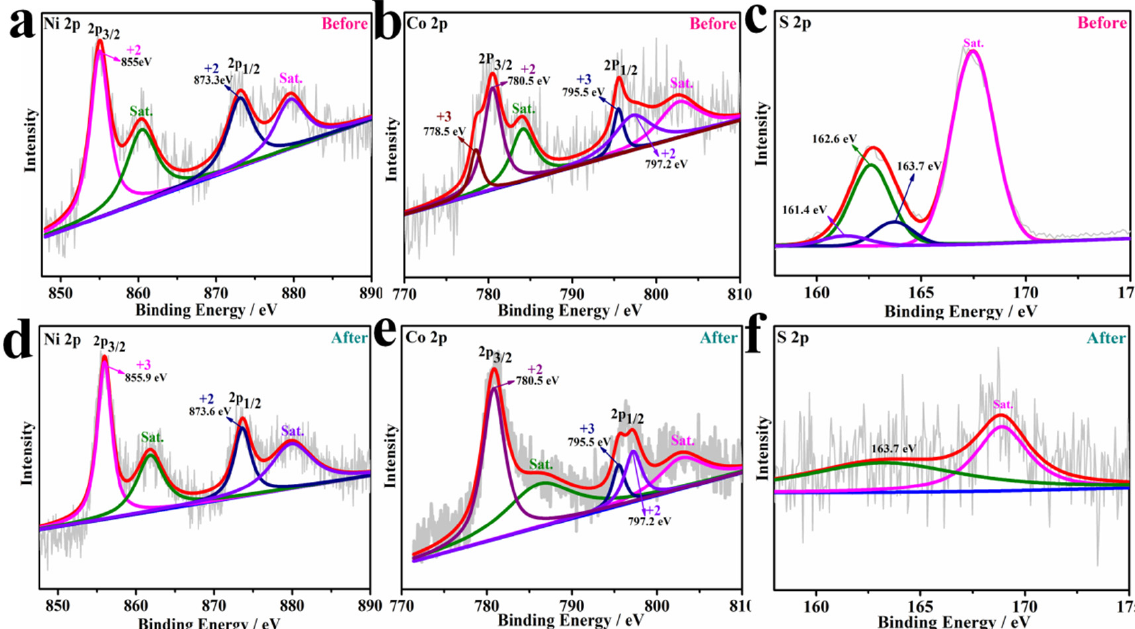
Figure 6. The XPS spectra of NiCo 2 S 4 -NiS 2 /CFP before and after 12 h durability tests: ( a , d ) Ni 2p, ( b , e ) Co 2p and ( c , f ) S 2p.